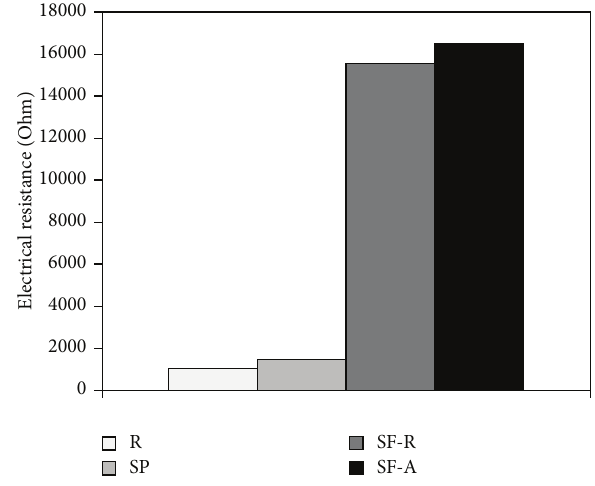
Figure 9: Electrical resistance at 60